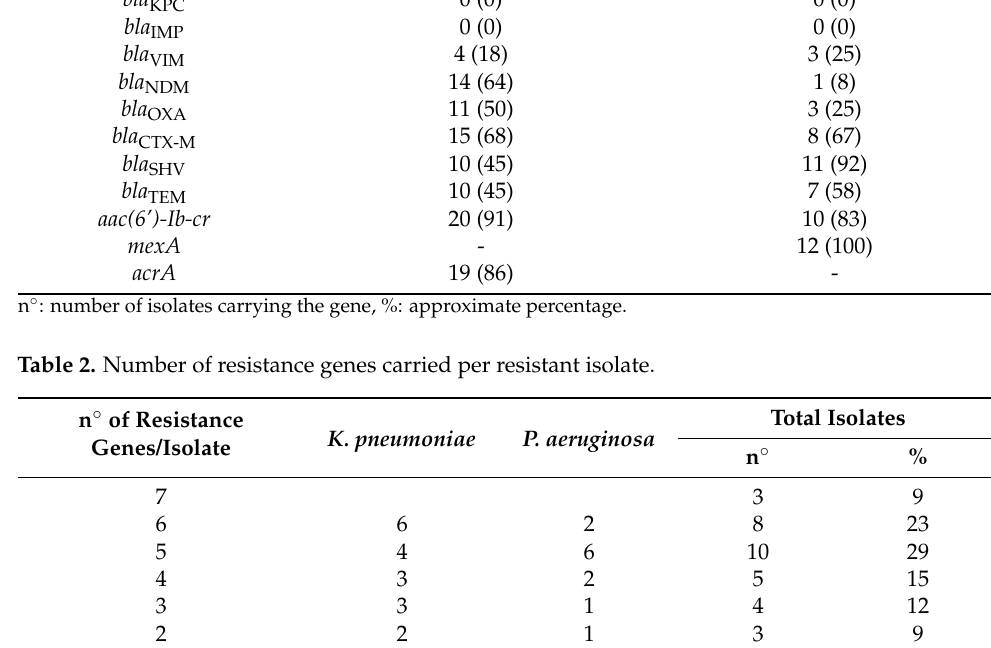
Table 1. Resistance genes detected in carbapenem-resistant Gram-negative pathogens (CRGNPs). Gene